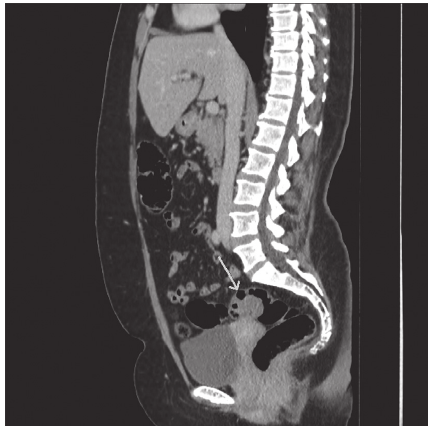
Figure 3: Sagital image of abdomen tomography with stenosing lesions in the upper rectum presenting impregnation with contrast, as shown by the pointing